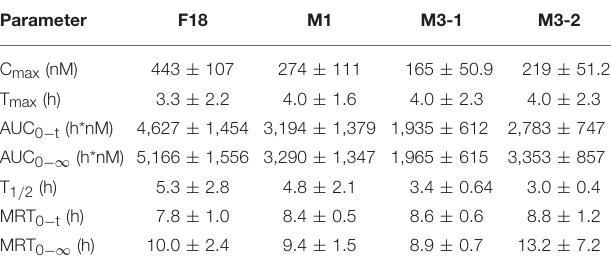
TABLE 5 | Pharmacokinetic parameters of F18 and its metabolites in rats after oral administration of F18 at 50 mg/kg.